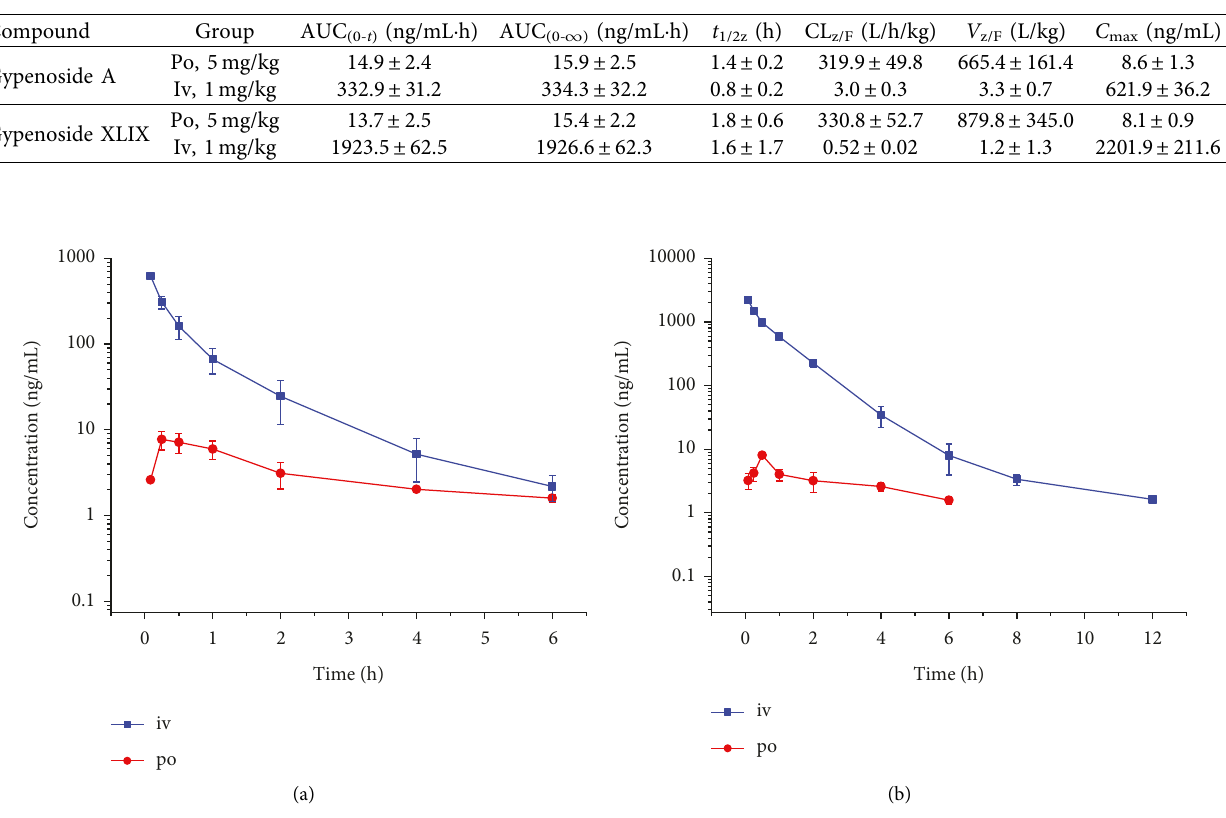
Figure 4: The concentration-time curve of rats after intravenous (iv, 1 mg/kg) and oral (po, 5 mg/kg) administration of gypenoside A (a) and gypenoside XLIX